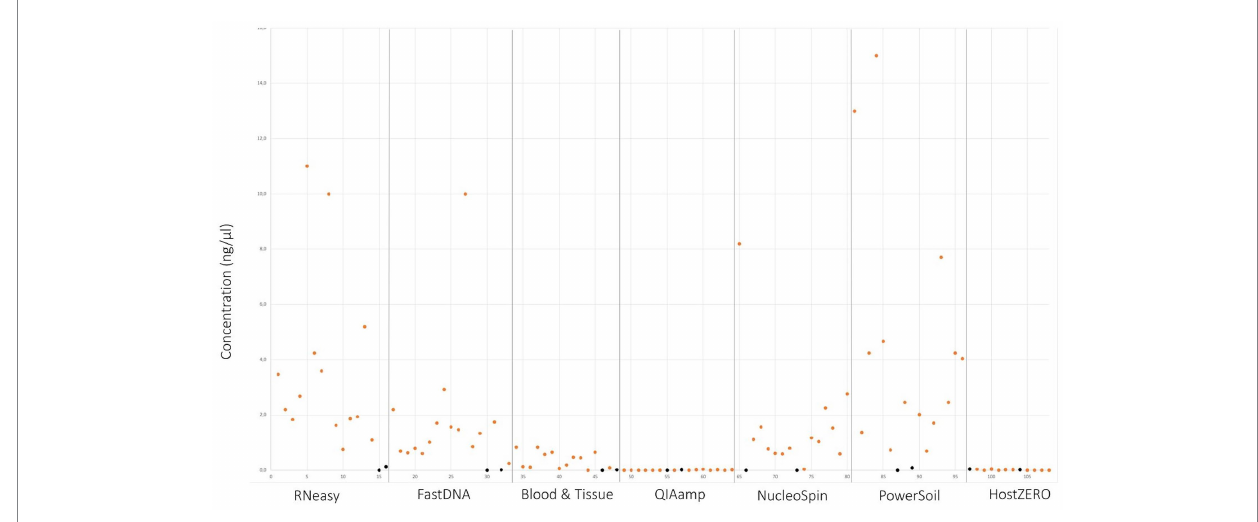
FIGURE 2 DNA yield per extraction protocol. Values in orange indicate the different sampling points. Values in black signifies controls and blank samples.